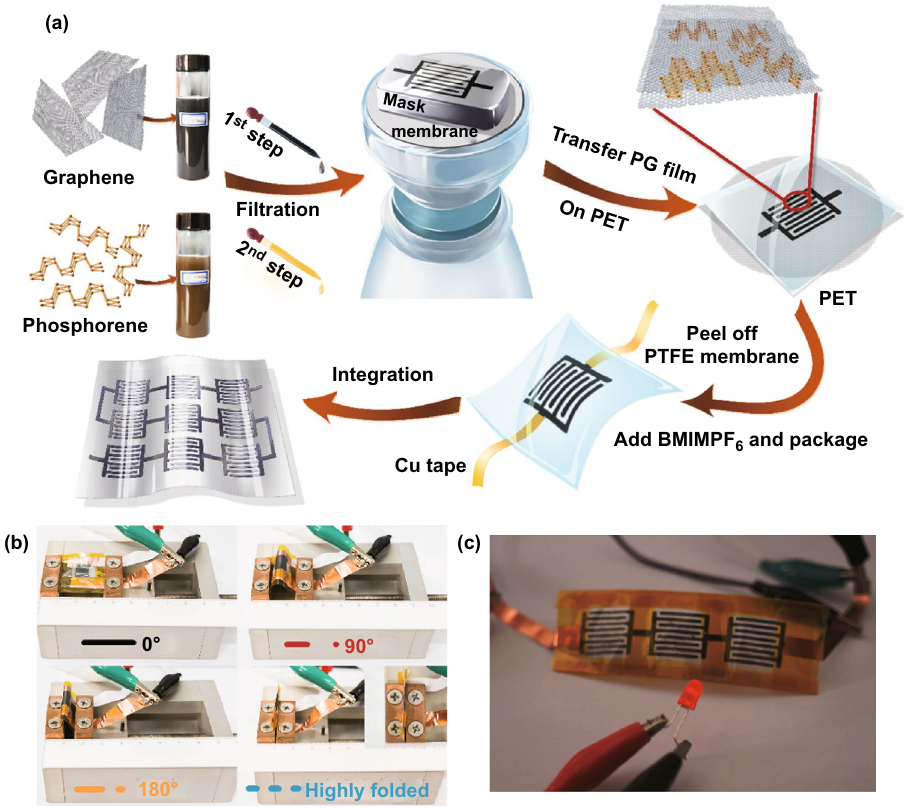
Fig. 14 a Illustration of the fabrication of PG-MSCs, which includes the following steps: synthesis of graphene and phosphorene inks; step- by-step filtration of graphene and phosphorene in sequence with the assistance of an interdigital mask; dry transfer of PG hybrid film onto PET substrate; peeling off the PTFE membrane, drop-casting electrolyte, and device package; integration of serially interconnected MSC devices. b Flexibility comparison of PG-MSCs and PG-SSCs: Photographs of PG-MSCs at different bending states. c Photograph of three serial PG-MSCs used to power a light-emitting diode (LED). Adapted with permission [235], Copyright 2017 American Chemical